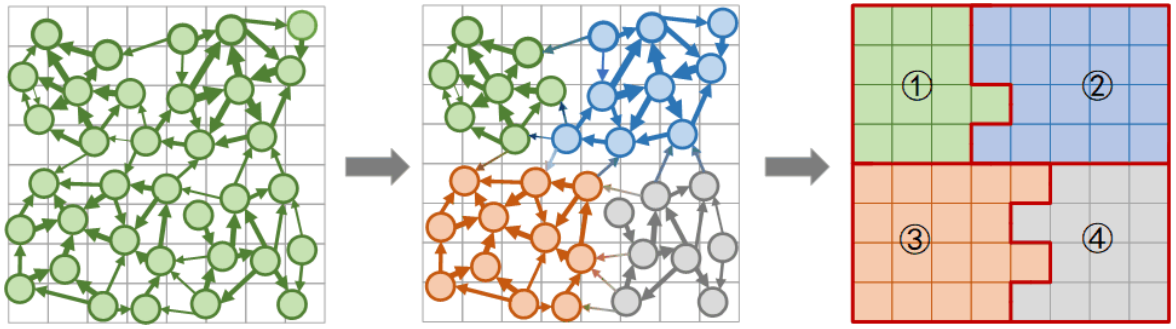
Figure 4. Identifying metropolitan area boundaries using community detection algorithms. (The circles in the figure show the region’s urban nodes; the various colors represent distinct urban clusters; the thickness of the directed lines indicates the strength of inter-city linkages; different numbers represent the delineation of each metropolitan area.).